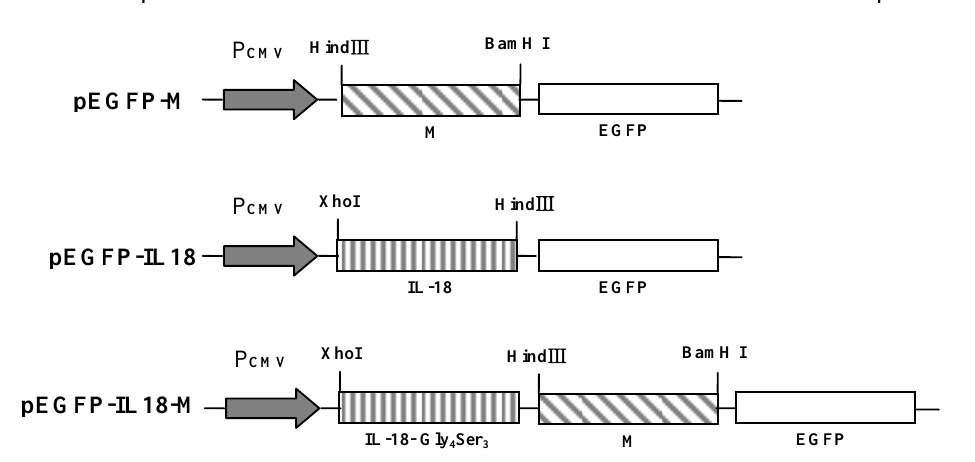
Figure 1. Schematic diagrams of recombinant plasmids—pEGFP-M, pEGFP-IL18 and pEGFP-IL18-M. pEGFP-N1 was used for the construction of the recombinant